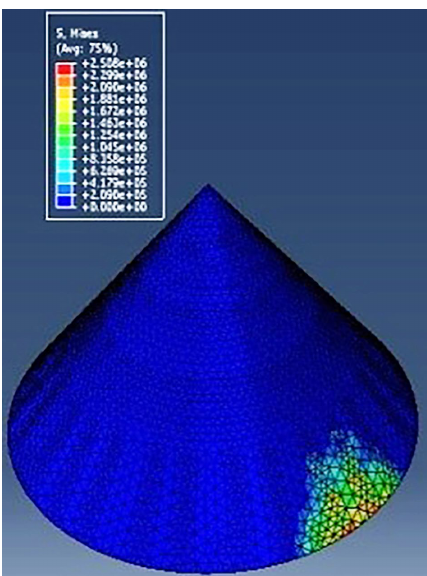
Fig. 11. Von misses composite stress contour in the frustum building while explosion strikes building in 10 meters high from ground